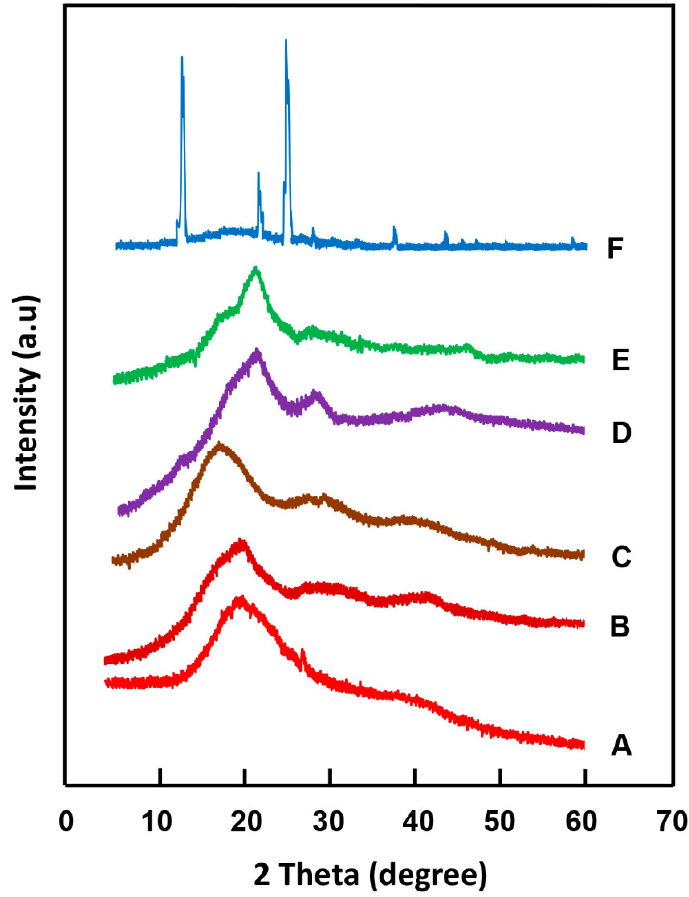
Figure 9. XRD patterns of: (A) PHEMA; CQMA- co -HEMA with different CQMA contents: (B) 5 wt%; (C) 7 wt%; (D) 10 wt%; (E) 15 wt% and (F) CQMA.